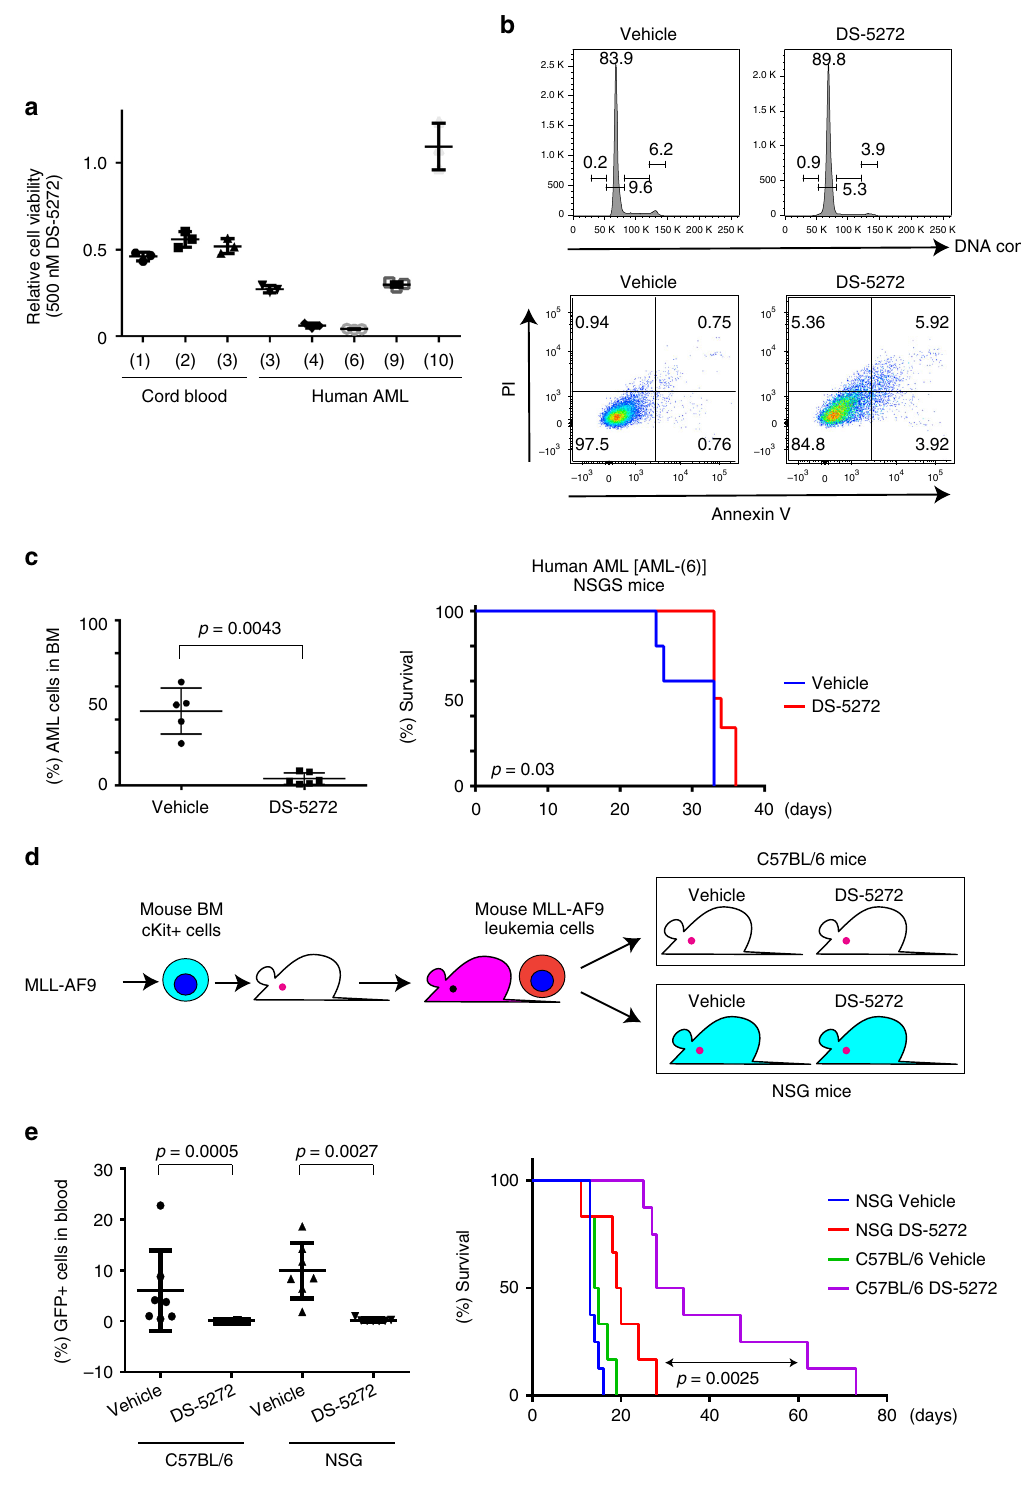
Mouse model for AML driven by MLL-AF9 . Mouse bone marrow progenitor cells (c-Kit + cells) derived from wild-type or Trp 53( − / − ) mice were transduced with MLL-AF9, and were transplanted intravenously into sublethally irradiated (525cGy) recipient mice. MLL-AF9-expressing leukemia cells were harvested from spleens of moribund mice, and were serially transplanted into recipient mice. The serial transplantation was subsequently repeated several times to generate MLL- AF9 cells with strong leukemogenicity. These wild-type and Trp 53( − / − ) MLL-AF9 cells (5× 10 5 cells/body) were injected intravenously into non-irradiated recipient mice. For drug studies, DS-5272 (Daiichi Sankyo) was dissolved in 0.5w/v% Methyl Cellulose 400 Solution (Wako, Japan), and 80 mg/kg/day of DS-5272 was